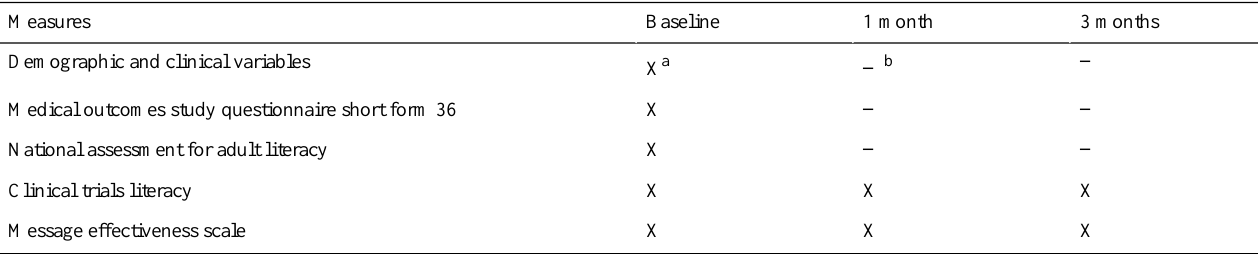
Table 1. Study outcome